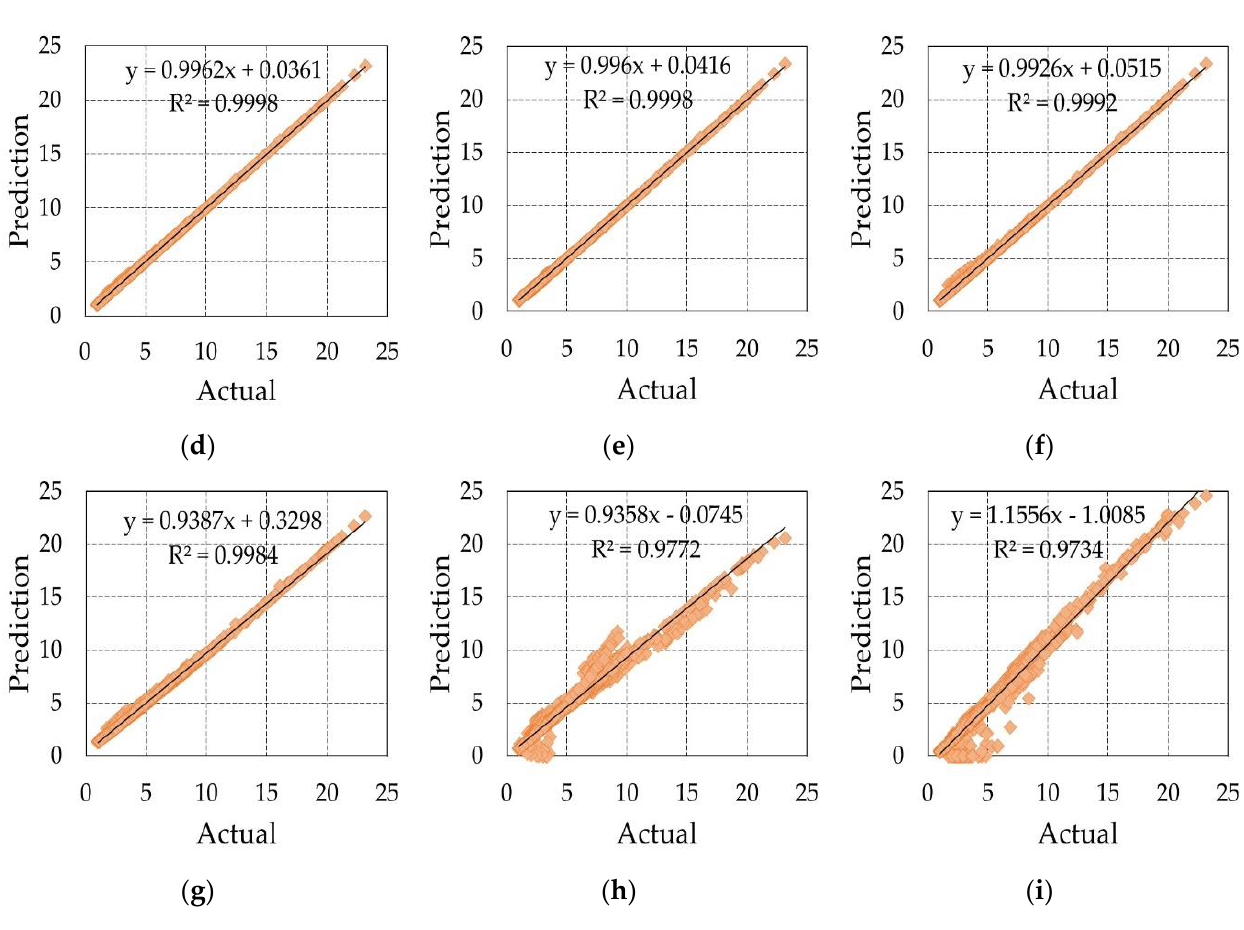
Figure 6. R 2 of prediction results of PM 2.5 concentration. ( a ) LM-Hidden layer-1; ( b ) LM-Hidden layer-3; ( c ) LM-Hidden layer-5; ( d ) BR-Hidden layer-1; ( e ) BR-Hidden layer-3; ( f ) BR-Hidden layer-5; ( g ) BFG-Hidden layer-1; ( h ) BFG-Hidden layer-3; ( i ) BFG-Hidden layer-5.